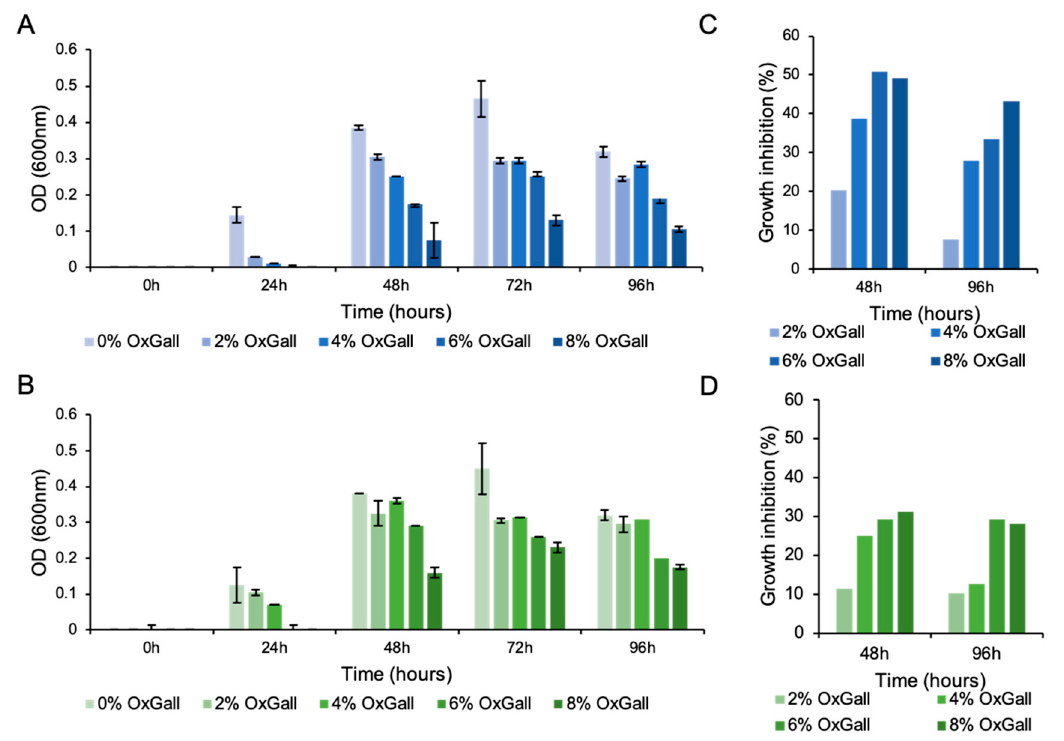
Figure 1. Bile acid resistance by Christensenella minuta DSM 33407. Bile acid resistance profile for ( A ) Christensenella minuta DSM 33407 and ( B ) C. minuta DSM22607 using OxGall as a source of bile salts. The percentage of growth inhibition was obtained by enumerating the CFU for ( C ) Christensenella minuta DSM 33407 and ( D ) C. minuta DSM 22607 after 48 h and 96 h of growth in the presence of the corresponding OxGall concentrations. All experiments were performed in triplicates except for the CFU enumerations (C and D; no replicate). Key: OxG: OxGall.